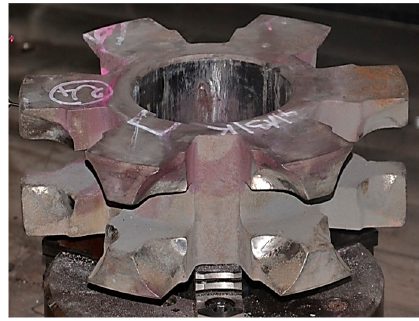
Figure 5. Test rig. ( A ) Rig (1—drive wheels, 2—turning wheels, 3—chains, 4—drive, 5—tensioner, 6—beaters, 7—main frame, 8—cover). ( B ) Testing chain drums filled with dry quartz abrasive.